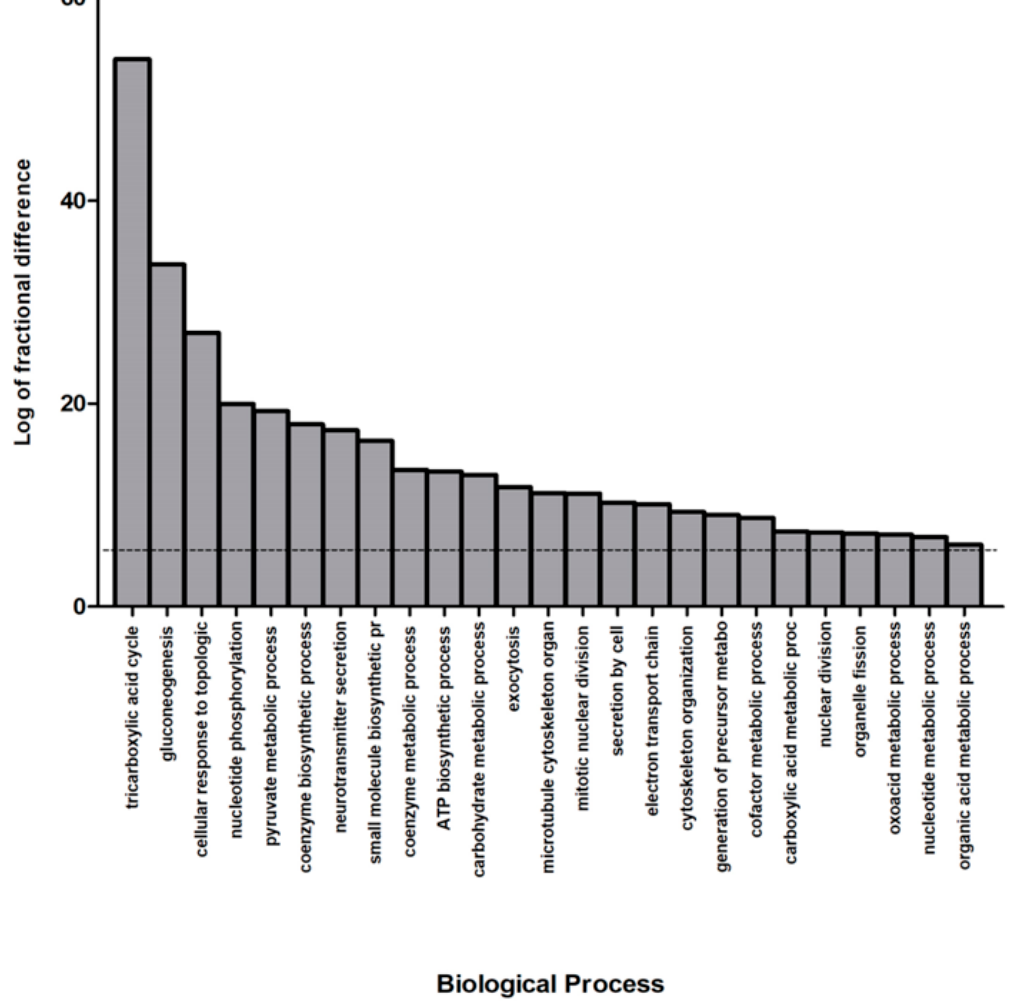
Figure 3. Biological process classification of murine NAGLU − / − brain tissue proteome. The di ff erentially expressed proteins in NAGLU − / − brain versus murine WT brain proteomes were clustered according to their gene ontology (GO) biological process using PANTHER software. The most significant biological processes are listed according to their enriched values, expressed as the log of fractional di ff erence (observed vs. expected): (number of genes for the category – number of genes expected) / (number of genes expected).